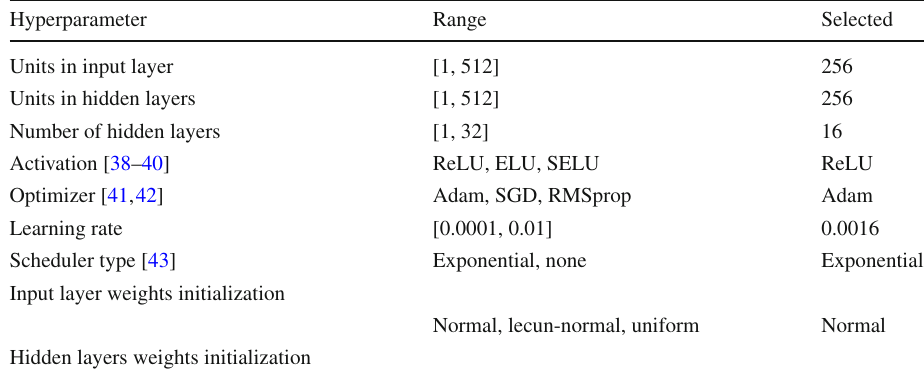
space for FCDNN. Selected hyperparameters are highlighted in